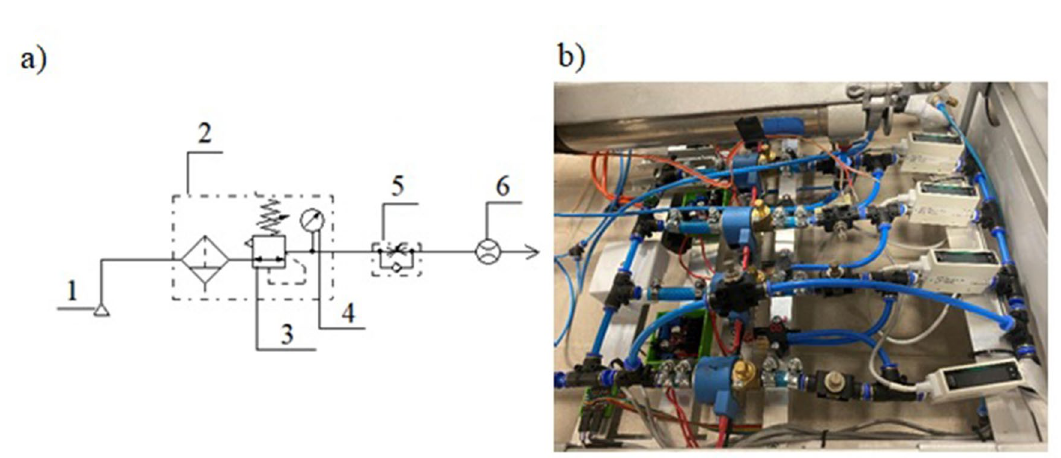
Figure 5. ( a ) Diagram of the test stand with a throttle-check valve: 1—power source—compressed air, 2—air preparation unit, 3—pressure reducing valve, 4—pressure gauge, 5—test element (throttle-check valve), 6—flow sensor; ( b ) The test rig. [The drawing ( a ) was created in the program: FluidSIM-P 5.0, Festo: https:// www. festo- didac tic. com/ int- en/ servi ces/ print ed- media/ manua ls/ fluid sim-5- user- guide. htm? fbid= aW50L mVuLj U1Ny4 xNy4z Mi44M jguNz c1OQ].